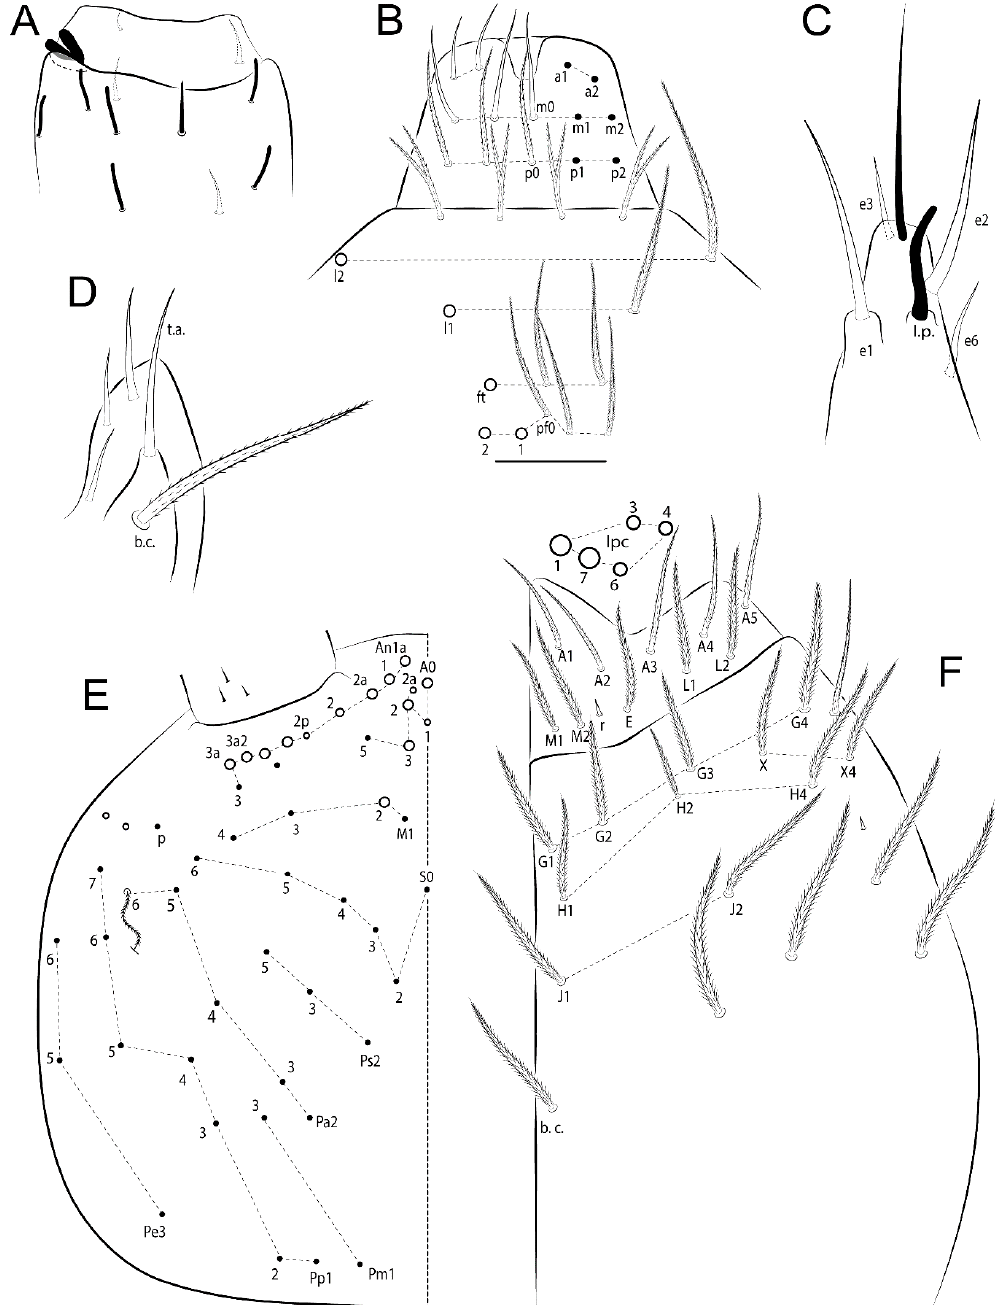
Figure 72. Pseudosinella parambigua sp. nov.: head. ( A ) Ant III apical organ (lateral view); ( B ) chaetotaxy of clypeus, prelabrum, and labrum; ( C ) labial papilla E (right side); ( D ) maxillary palp and sublobal plate (left side); ( E ) head dorsal chaetotaxy (left side); ( F ) labial proximal chaetae, basomedian and basolateral labial fields, and complete postlabial chaetotaxy (right side)..